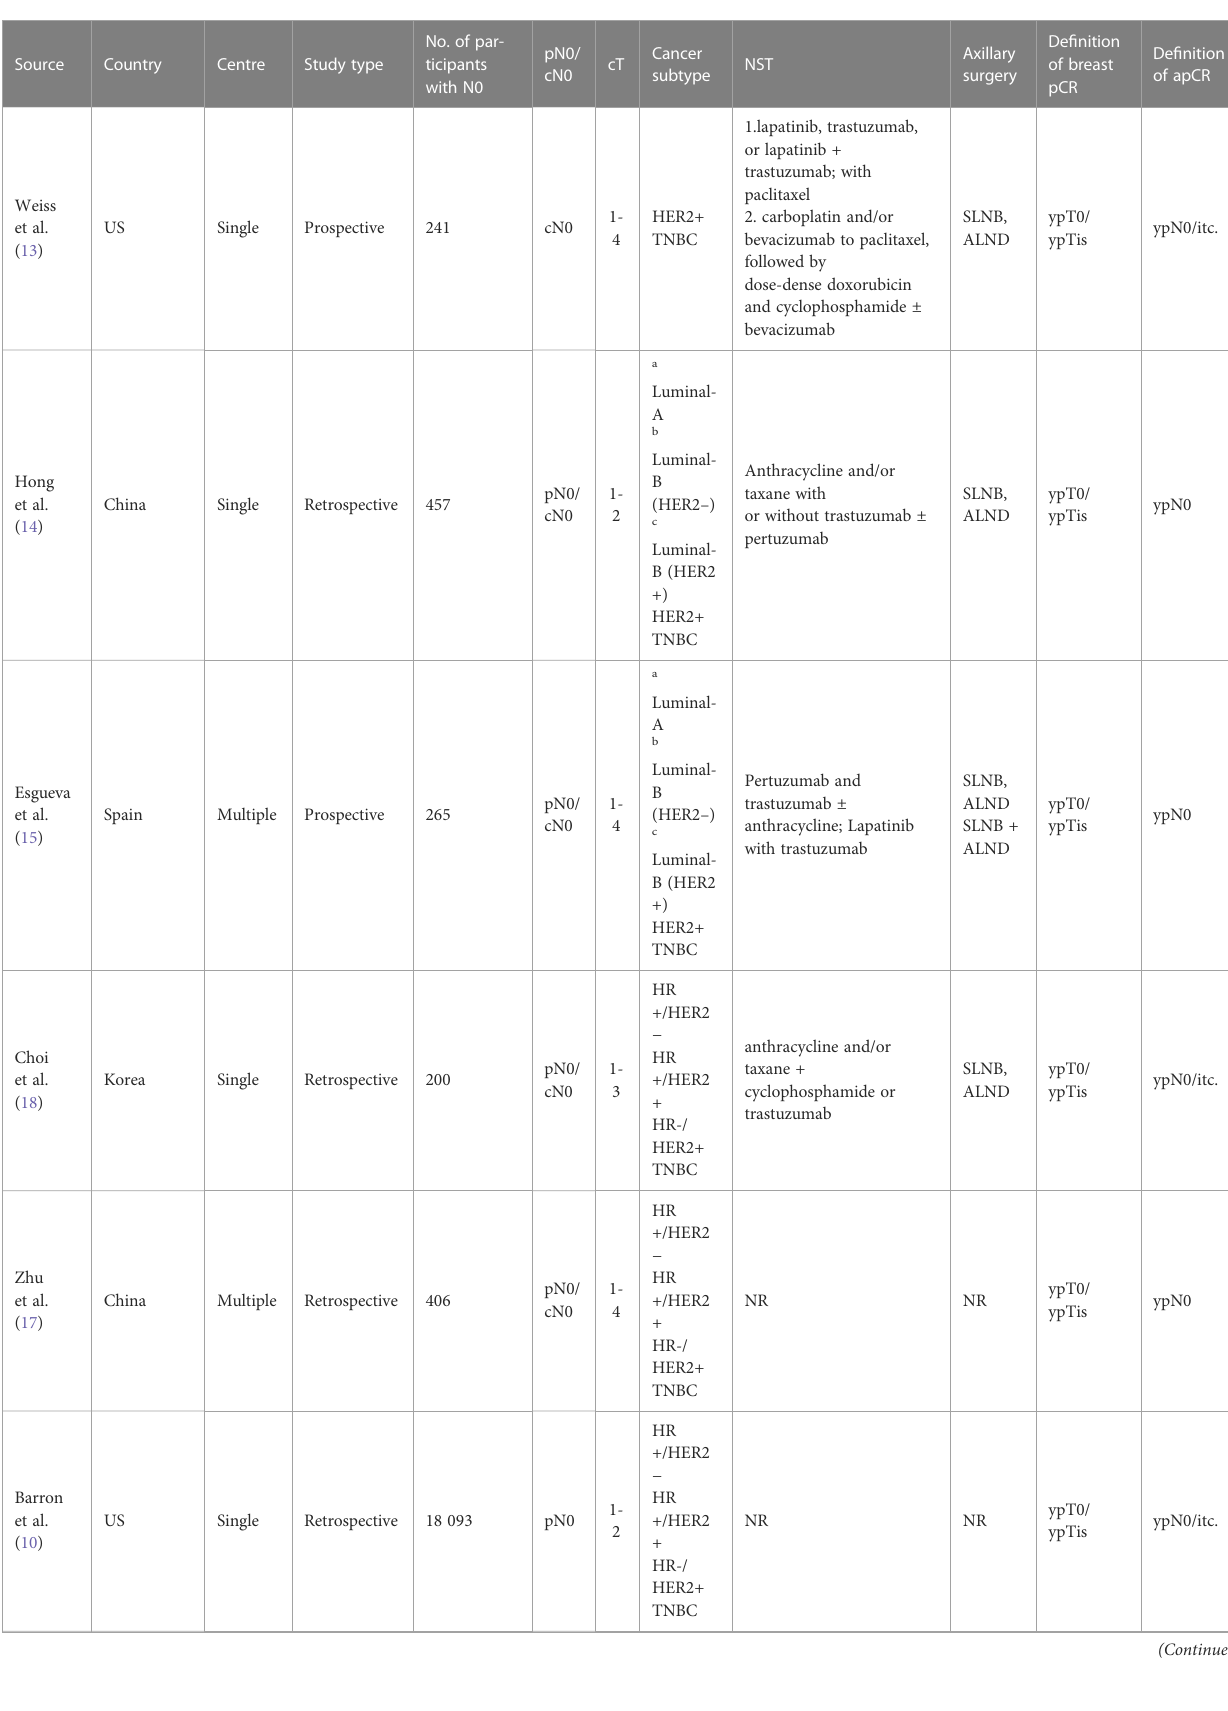
TABLE 1 General characteristics of the studies included in the